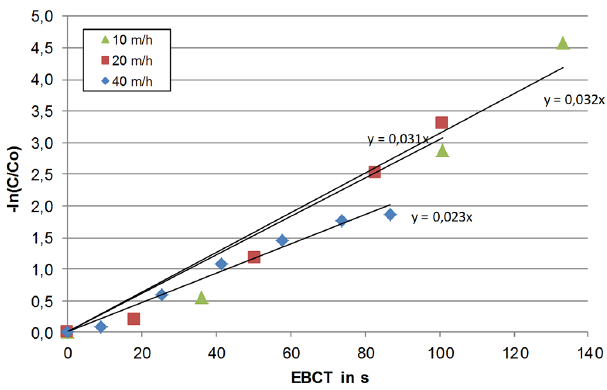
Figure 8. Decomposition with GAC at di ff erent water temperatures. Figure 7. Decomposition with GAC at different water tempera- tures.